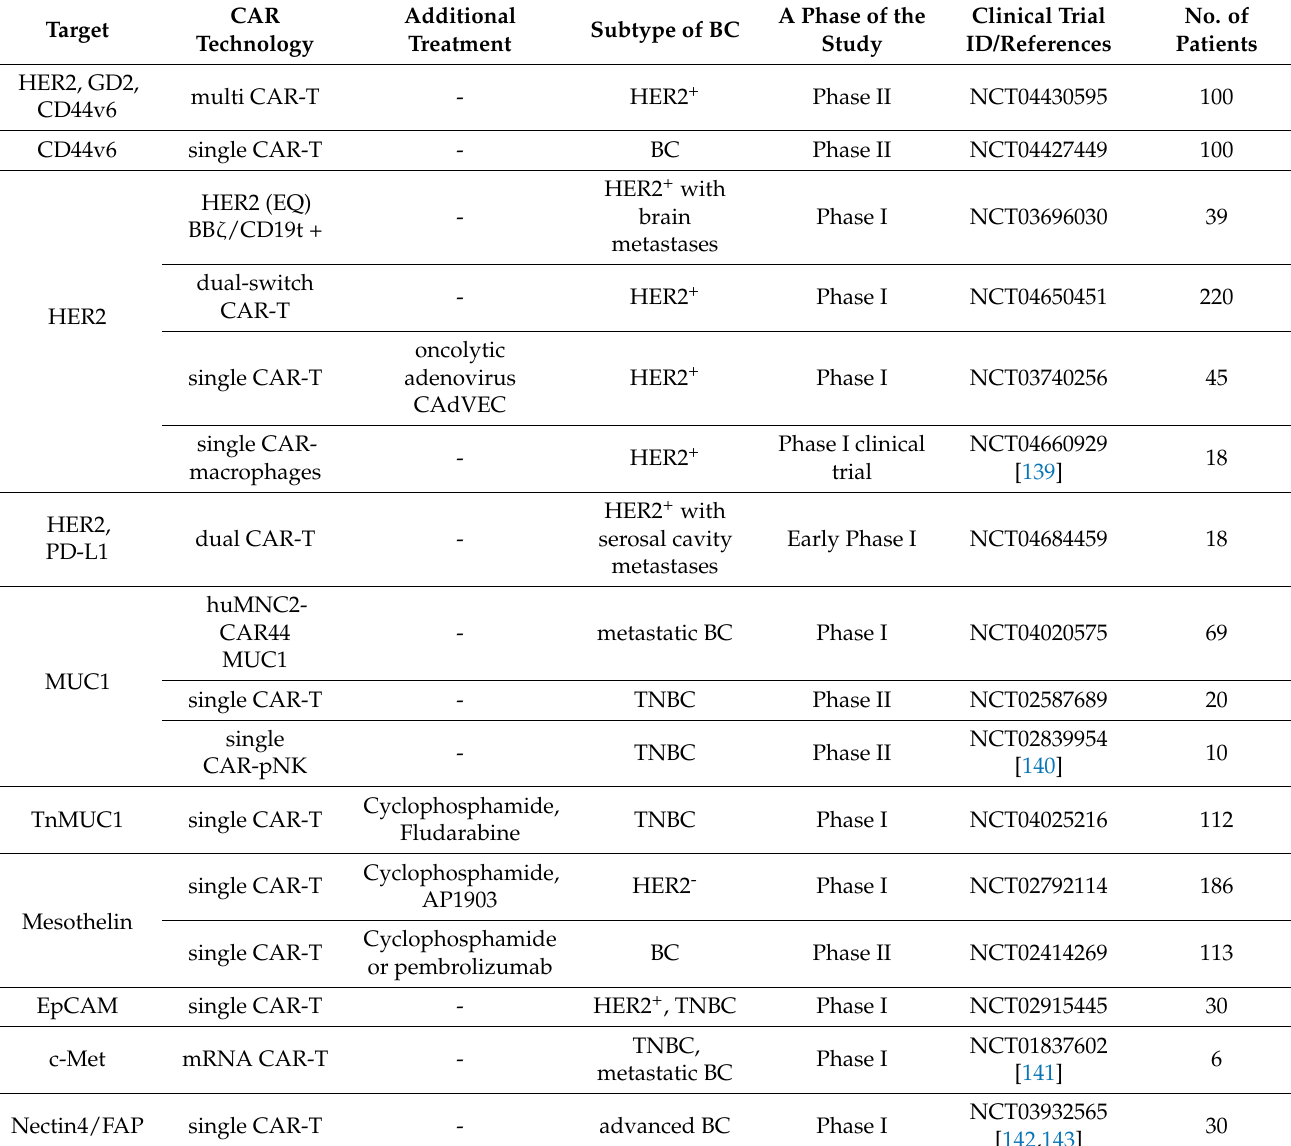
Table 4. Overview of the clinical trials in breast cancer with the application of the CAR-based strategies.